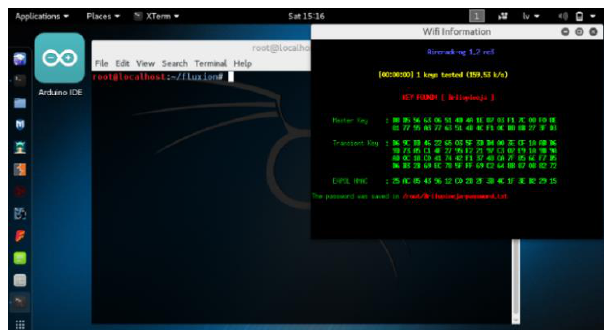
Fig. 9. Screenshot of Kali Linux destkop with the acquired password of the “Briivpieeja” network. The malicous network has been shut down because the pasword has been